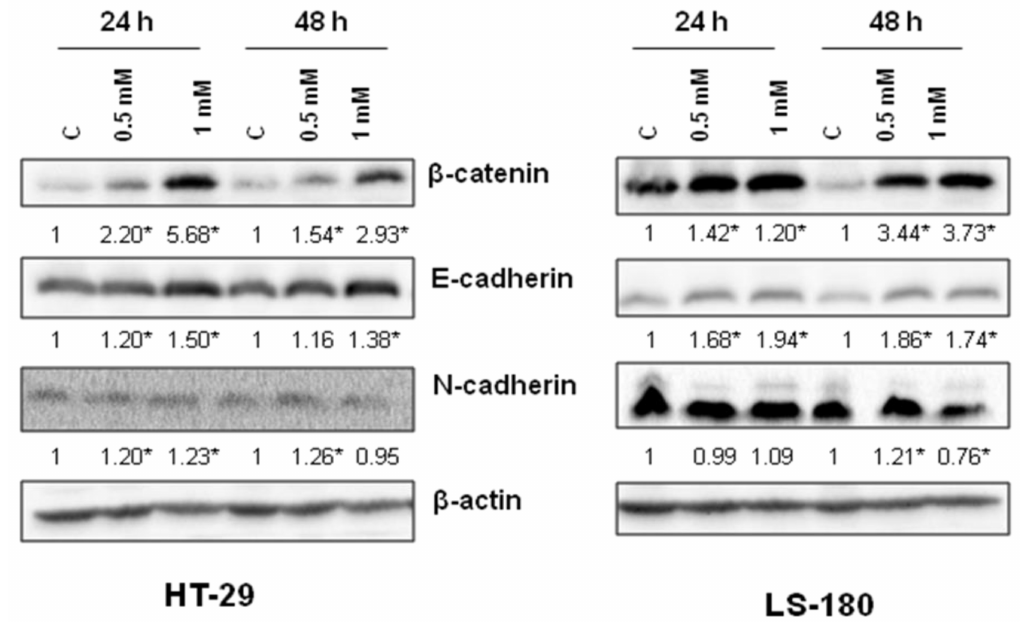
Figure 7. The e ff ect of 8-hydroxyquinaldic acid on expression of β -catenin, E- and N-cadherin in human colon adenocarcinoma cells. Western blot analysis of expression of β -catenin and E- and N-cadherin was performed after 24 and 48 h treatment of HT-29 and LS-180 cells with 8-hydroxyquinaldic acid (0.5, 1 mM). Western blots presented above were selected as the most representative of the series of repetitions n ≥ 3. The data were normalized relative to β -actin and calculated fold changes in protein expression marked (fold changes ≥ 0.20 were considered as significant